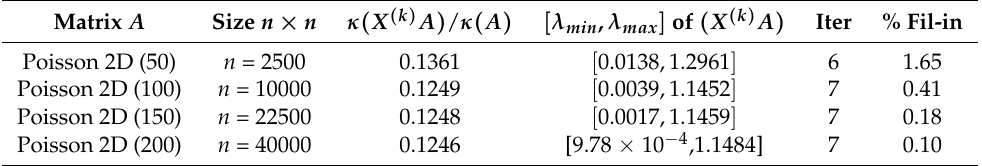
Table 5. Performance of MinCos applied to the Poisson 2D matrix, for different values of n and